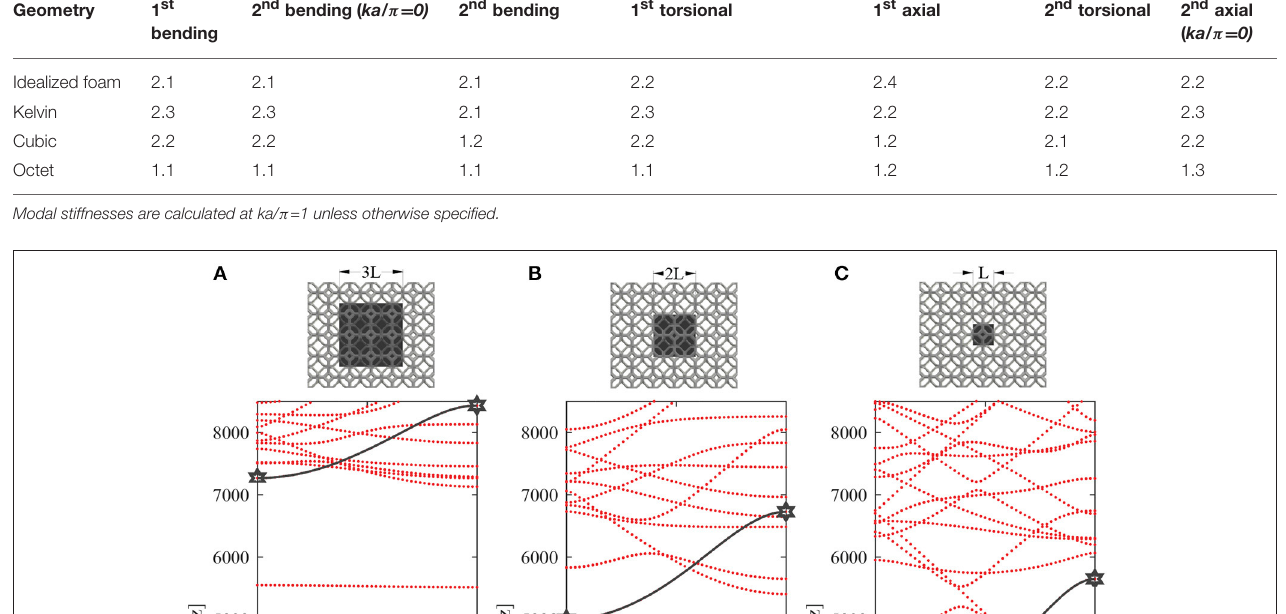
( Table 2 ) for cubic, idealized foam, and Kelvin metastructures. In the octet metastructure, a slight difference between scaling exponents is observed (about 16%). This may be due to the higher frequency nature of this mode. Dynamic effects seem to introduce bending deformation of the lattice struts, raising the scaling exponent. Like the 2nd bending mode, we observe a transition on lattice property dependence of the 2nd axial mode as wavenumber increases. In the long wavelength region, the modal stiffness seems to depend on a combination of E lattice and G lattice . However, since this side of the k -space does not define any of the band gaps of interest, we will not go into further